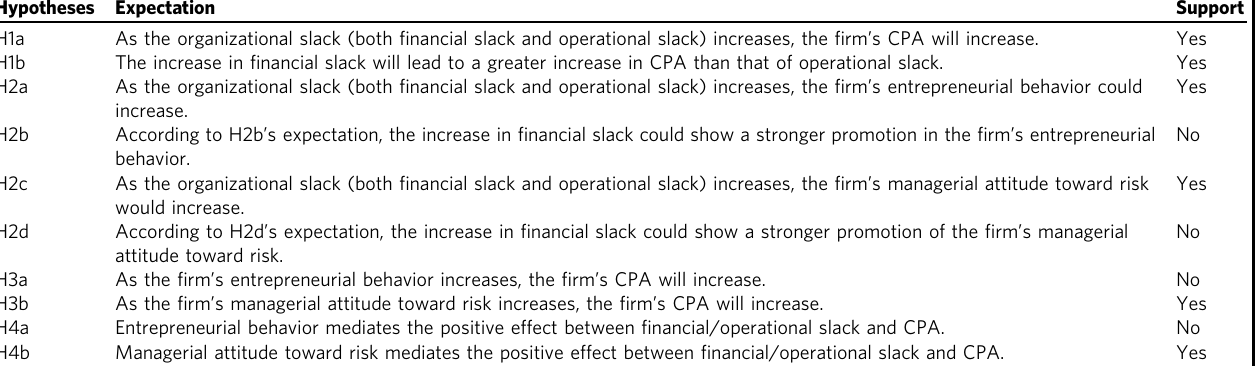
Table 6 Hypotheses